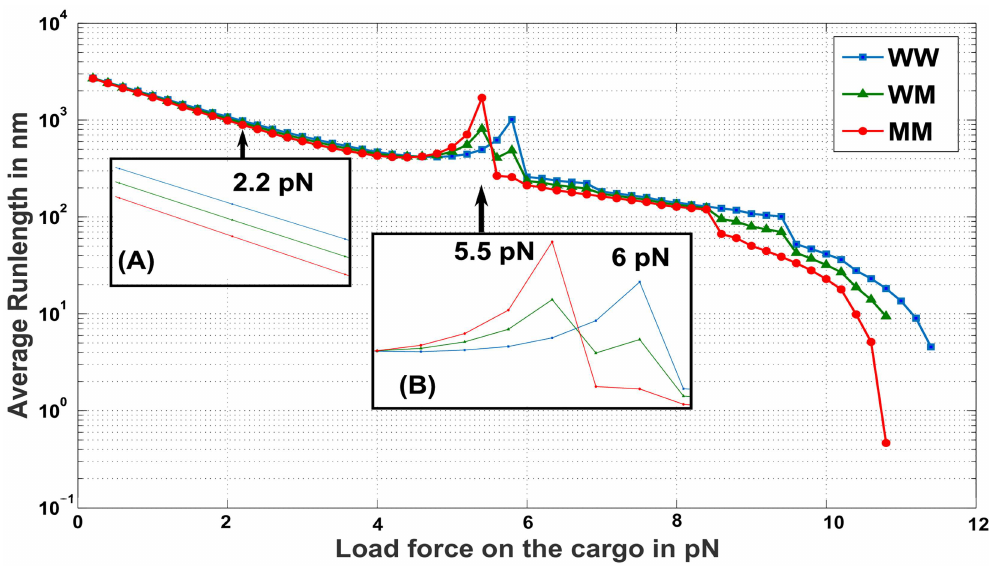
Fig 9. Average Run-length under different load forces on a cargo with ensembles of two motors, wild type and mutant (WW, WM and MM). (A) Average Run-lengthof ensembles subjected to load forces around 2.2 pN . Ensembleswith a higher proportionof mutant motors demonstrate lower average run-length than the rest of the ensembles. (B) Average Run-length of ensemblessubjected to load forces around (cid:22) F ¼ 5 : 5 pN , ensembleswith more mutant motors travel farther, whereas near F s = 6 pN , ensembleswith Near (cid:22) F s more wild-type motors travel farther.